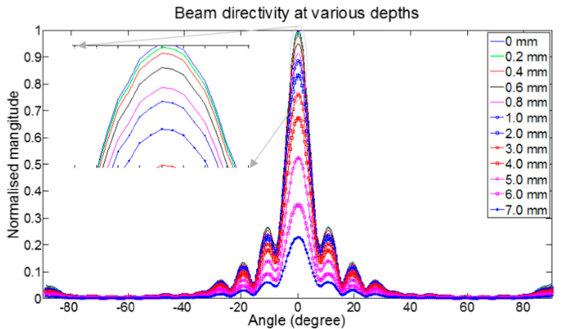
Figure 15. The simulated beam directivity of Rayleigh waves at various depths.